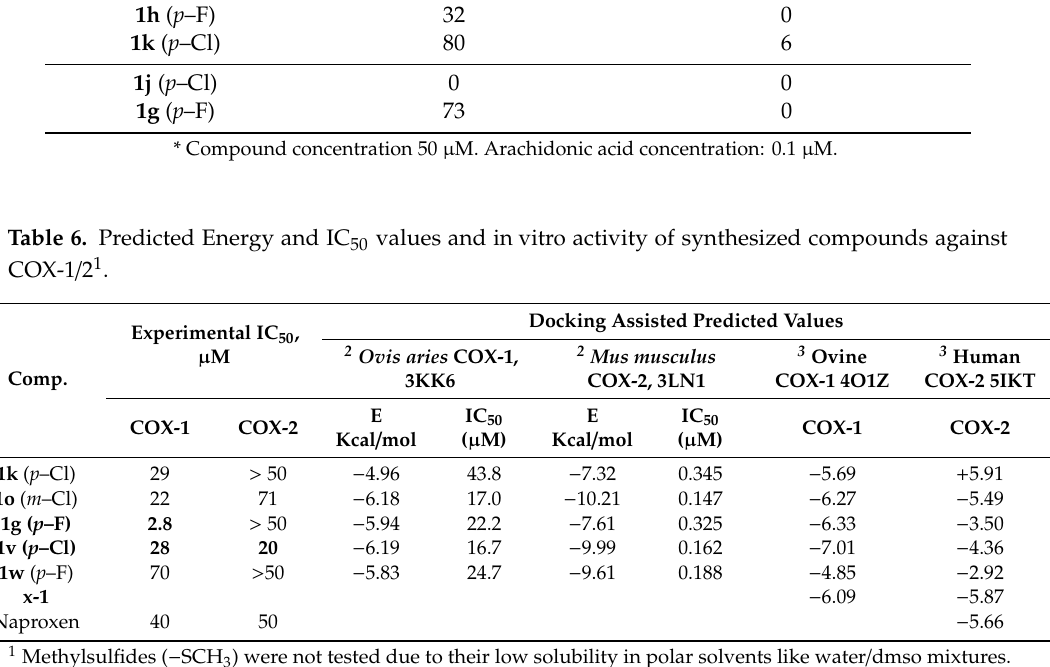
Table 5. Inhibition % of COX-1 / 2 isoenzymes *.